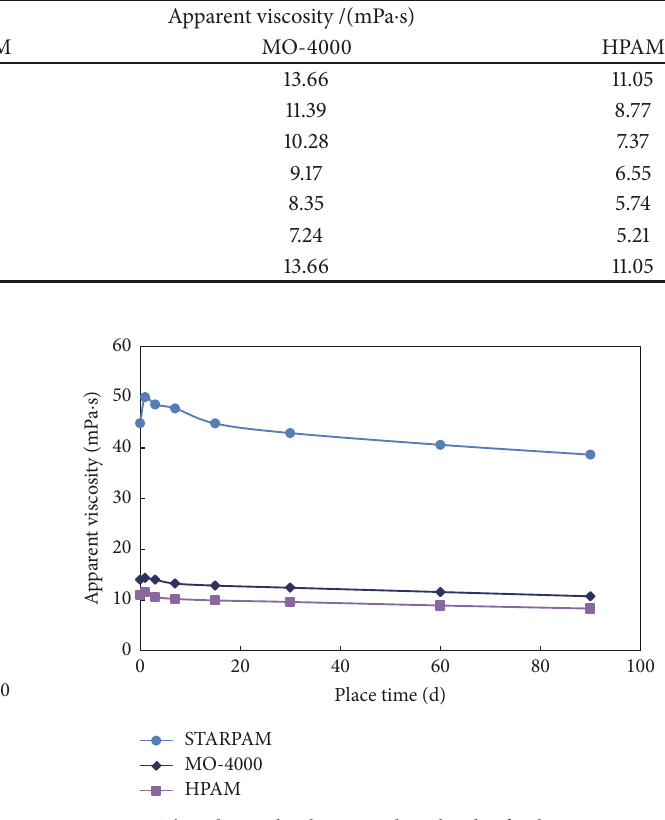
Figure 6: The relationship between three kinds of polymer viscosity and aging time (75 ∘ C, high purity nitrogen and vacuum deoxidiza-